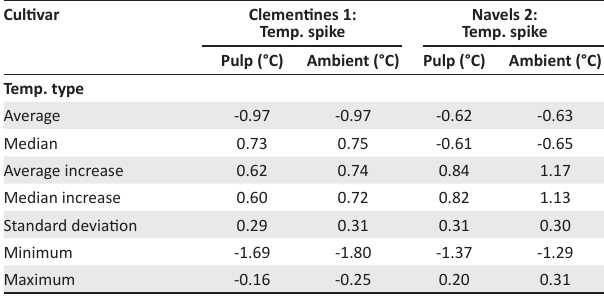
TABLE 5: Temperature dispersion of clementines load one and navels load 2: steri. Cultivar Clementines 1: